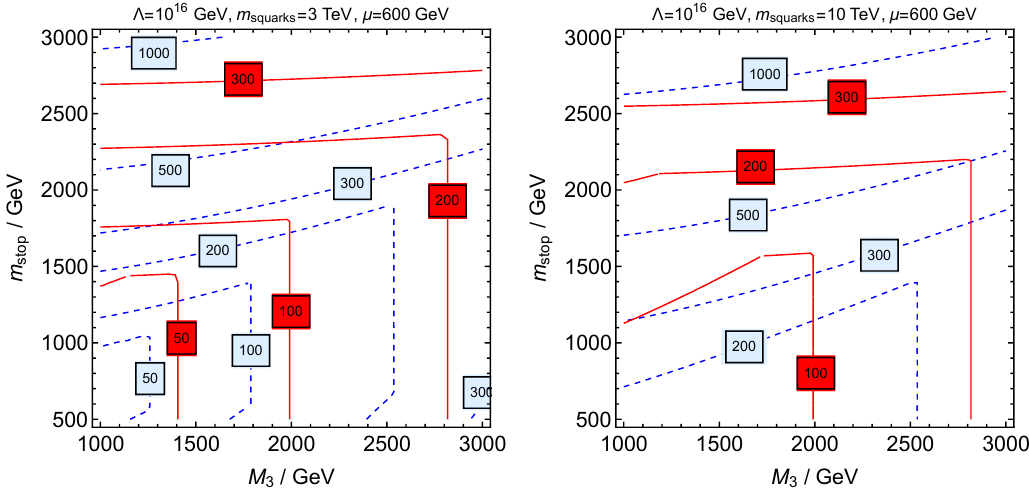
Figure 3 . The same as in (cid:12)gure 2 but for (cid:22) = 600